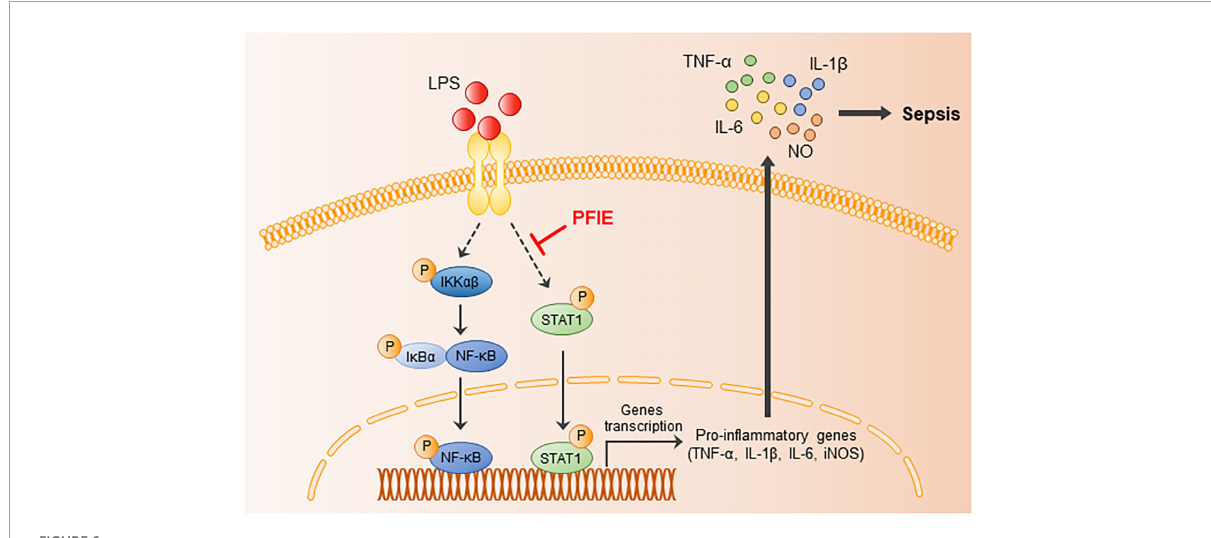
FIGURE6 The possible inhibitory pathways of PFIE in